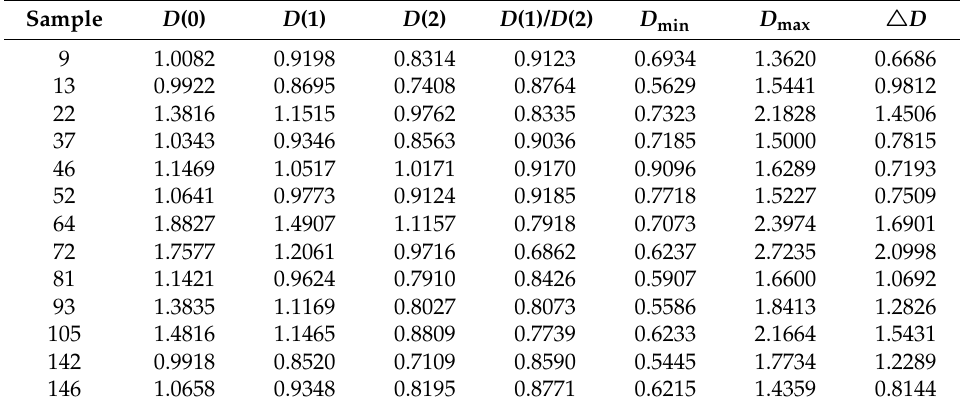
Table 4. Multifractal dimension parameters obtained from the 13